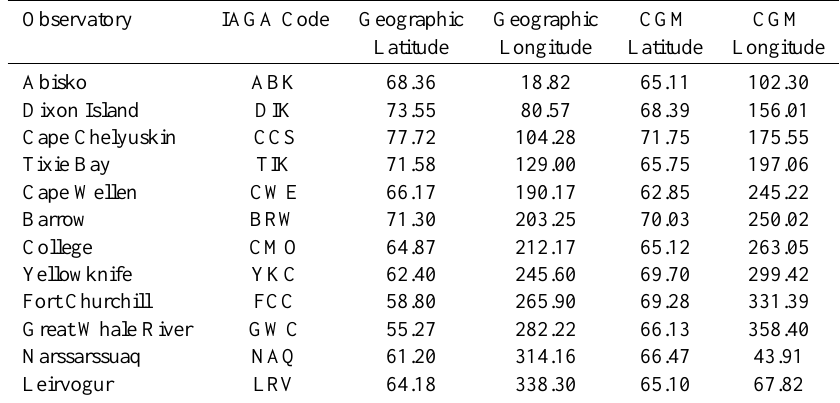
Table 1. Geographic coordinates and corrected geomagnetic coordinates for the 12 AE stations.